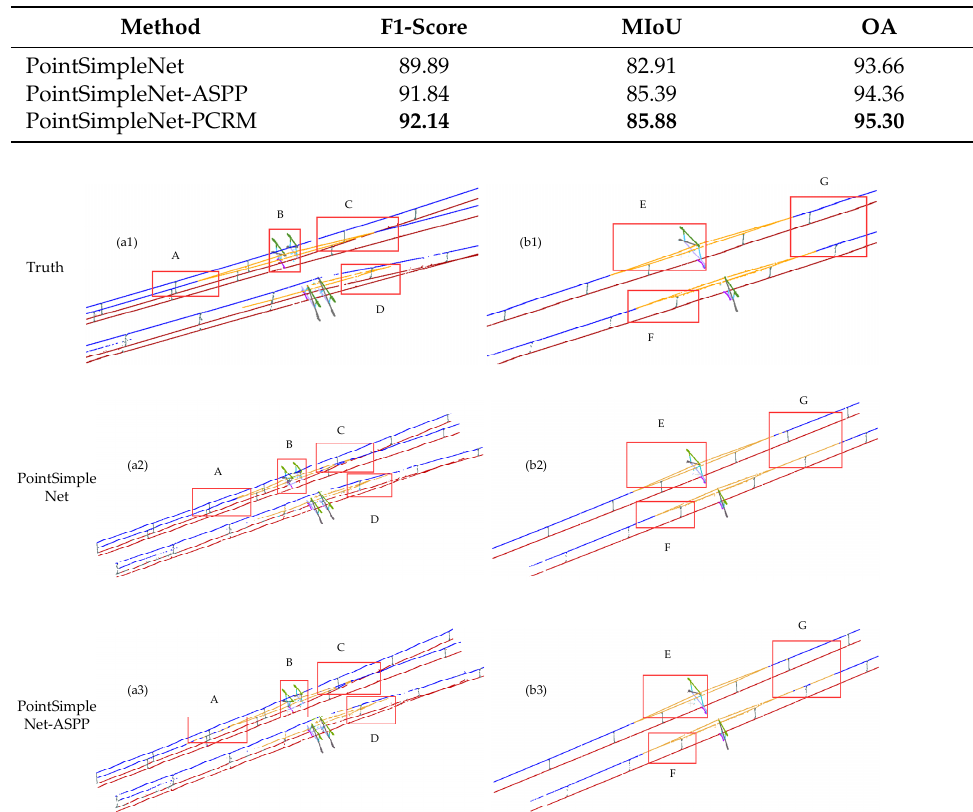
Table 8. Quantitative evaluation of refinement module PCRM through three groups of comparative experiments (%) on the OCS point cloud dataset. The best metrics are highlighted in bold.